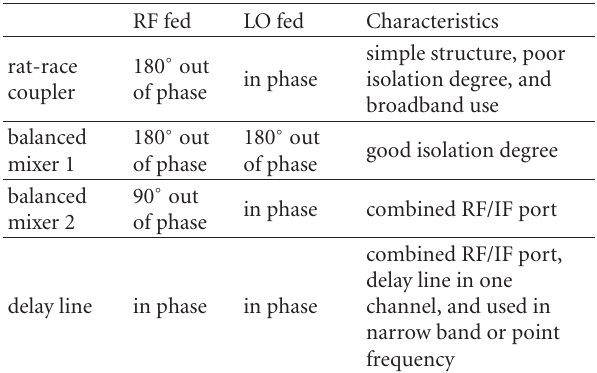
Table 1: Comparison of the phase conjugation mixers using bal- anced